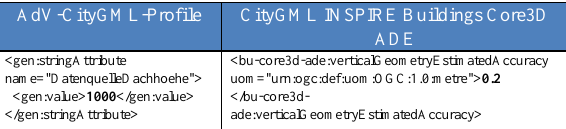
Table 3. Code example to compare attributes for geometric